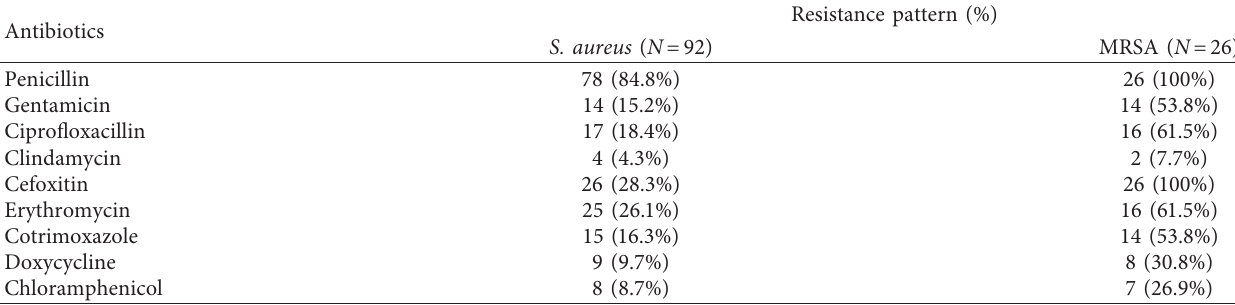
Table 2: Antibiotic resistance pattern of S. aureus and MRSA from wound infection in Dessie Referral Hospital.